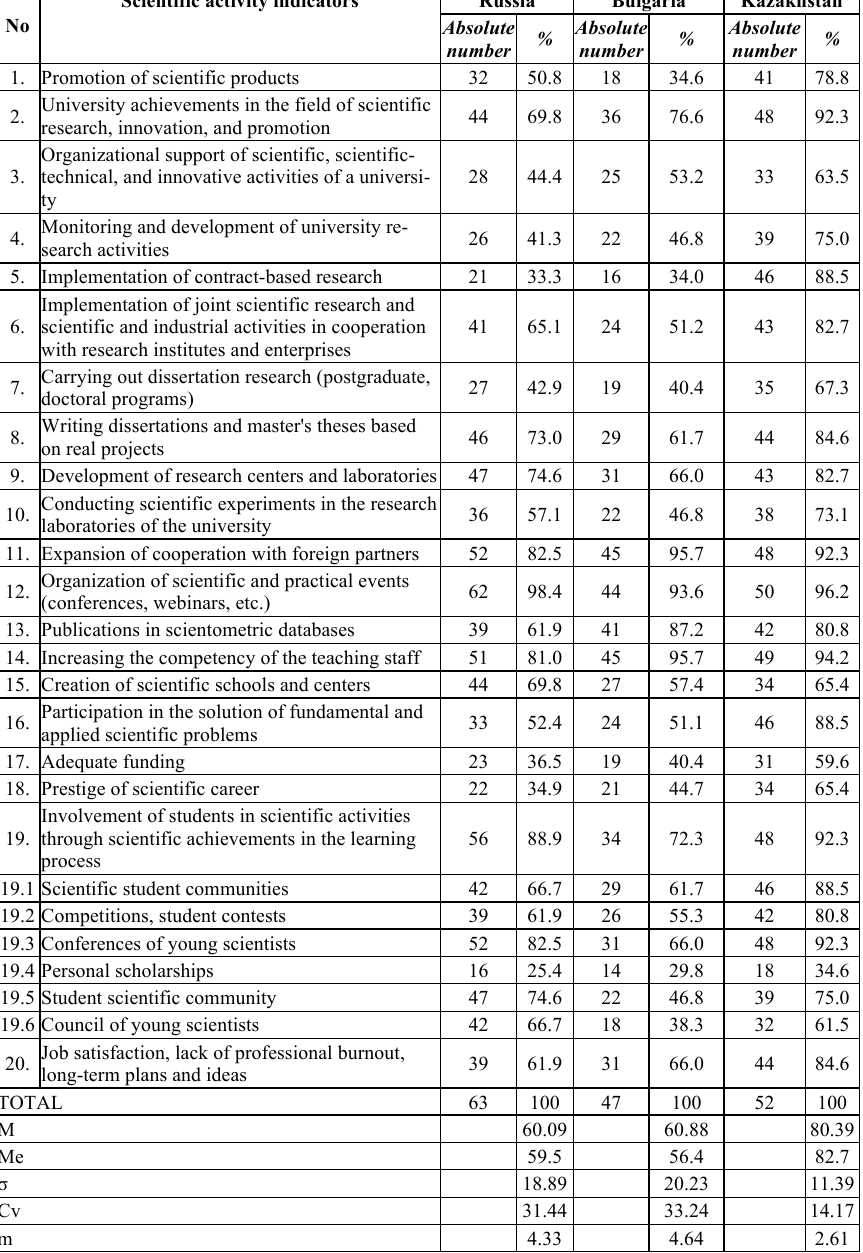
Table 1. Comparative analysis of the subjective assessment of scientific and scientific- technical activities of agrarian and economic universities in Russia, Bulgaria and